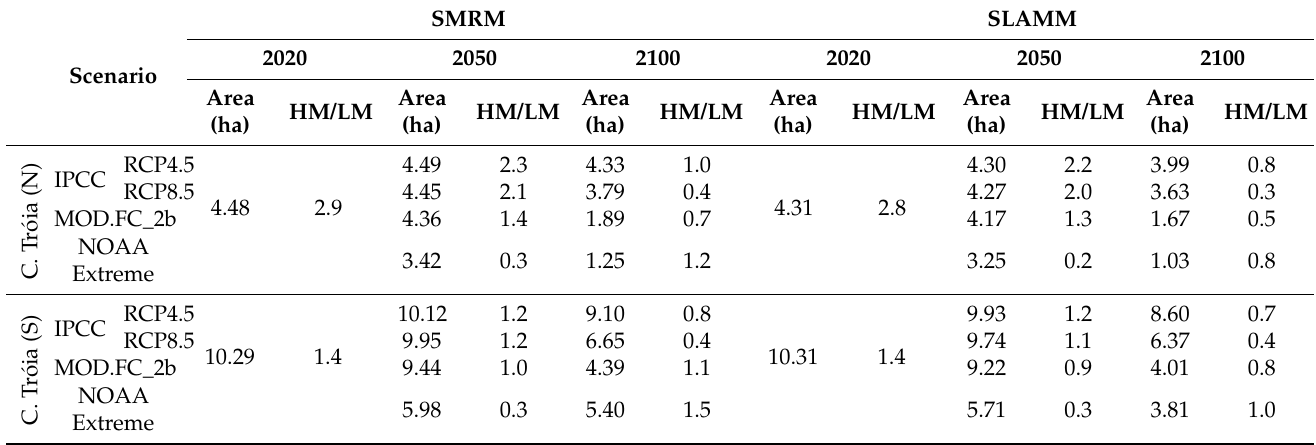
Table 4. Area and HM/LM ratio values for 2020, 2050, and 2100 for C. Tr ó ia (N) and C. Tr ó ia (S) salt marshes, considering IPCC RCP4.5/RCP8.5, MOD.FC_2b, and NOAA Extreme SLR scenarios using SMRM and SLAMM.